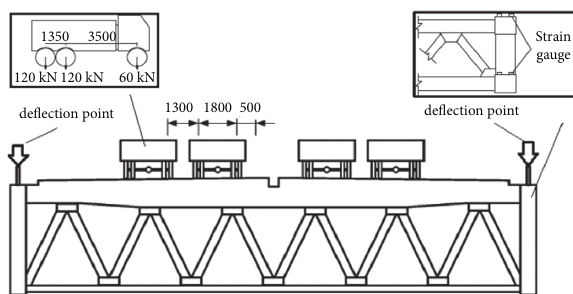
Figure 9: Cross-sectional view and load paths (units: mm).